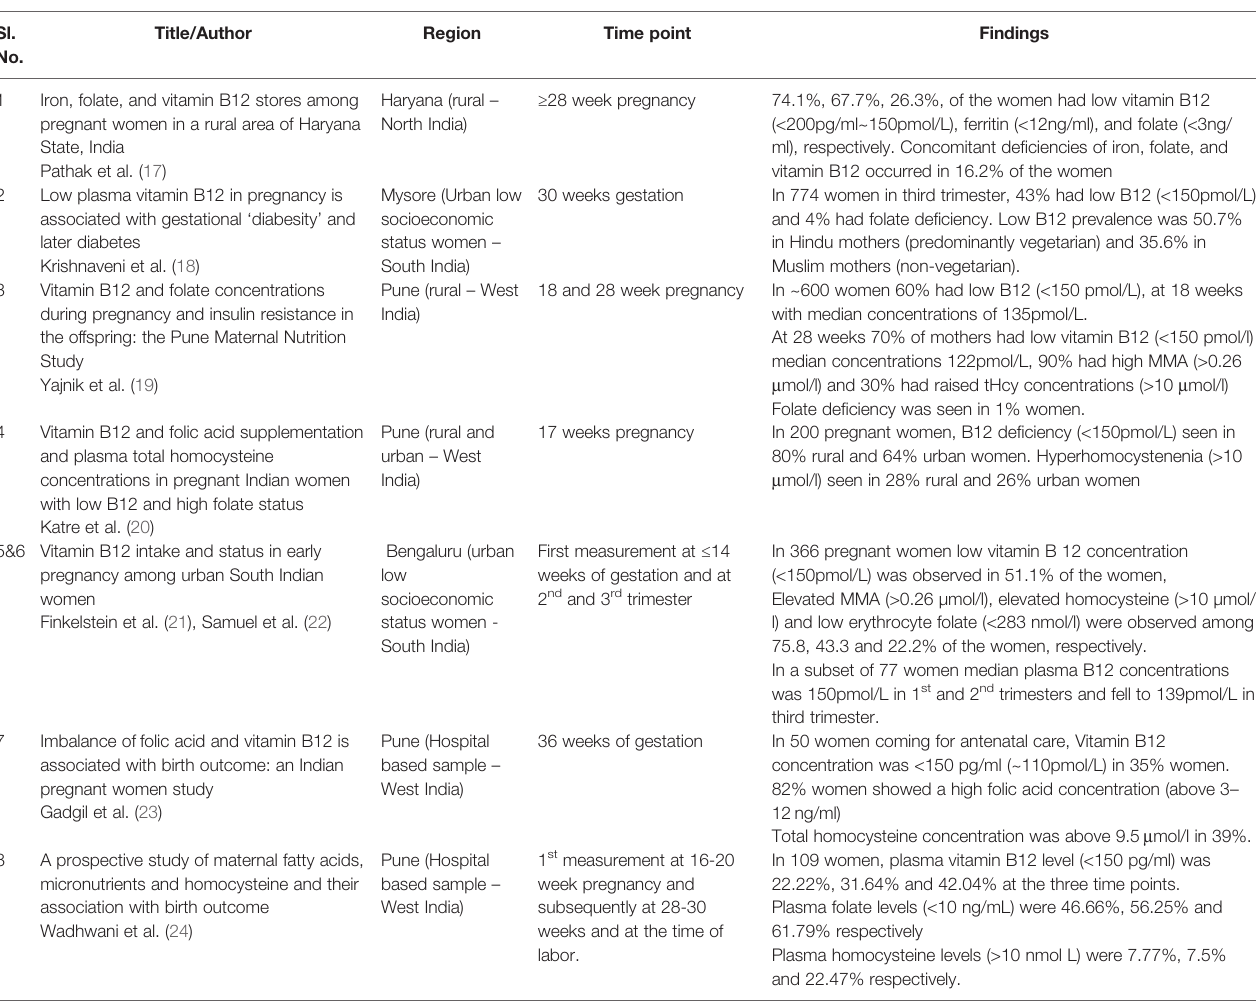
TABLE 1 | Indian studies on prevalence of vitamin B12, folate de fi ciency, or hyperhomocysteinemia during pregnancy. Sl.